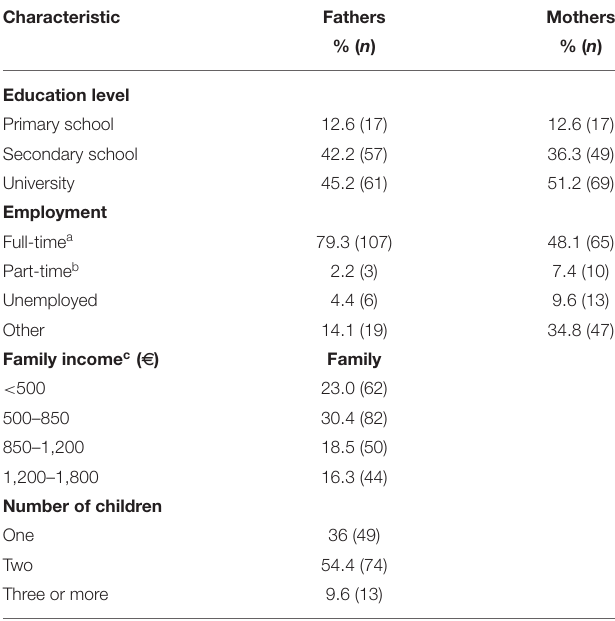
TABLE 1 | Parents’ sociodemographic characteristics and family